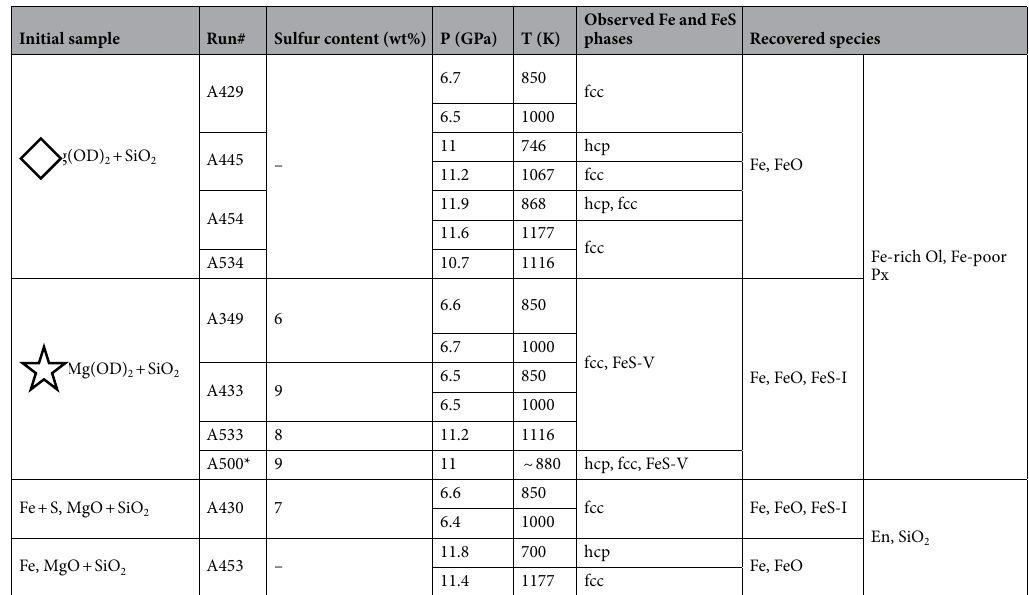
Table 1. List of experiments ordered by run number (Run#) and starting materials, involving the presence or absence of water and sulfur. The measurement of Fe and FeS phases was performed by neutron diffraction at high-PT conditions, and run products were identified from the recovered samples by SEM–EDS and XRD analyses. Symbols (star, diamond) for hydrous samples with/without S correspond to those presented in Figs. 1 and 3. *Blowout occurred during the long-duration experiment in #A500. FeS–I (troilite) and FeS–V denote the ambient and Ni–As type of high-PT phases of iron sulfide, respectively. Observed silicates are olivine (Ol), pyroxene (Px), and/or enstatite (En). Uncertainties on pressures and temperatures during the long-duration experiments are ± 0.2 GPa and within 3 K, respectively (see main